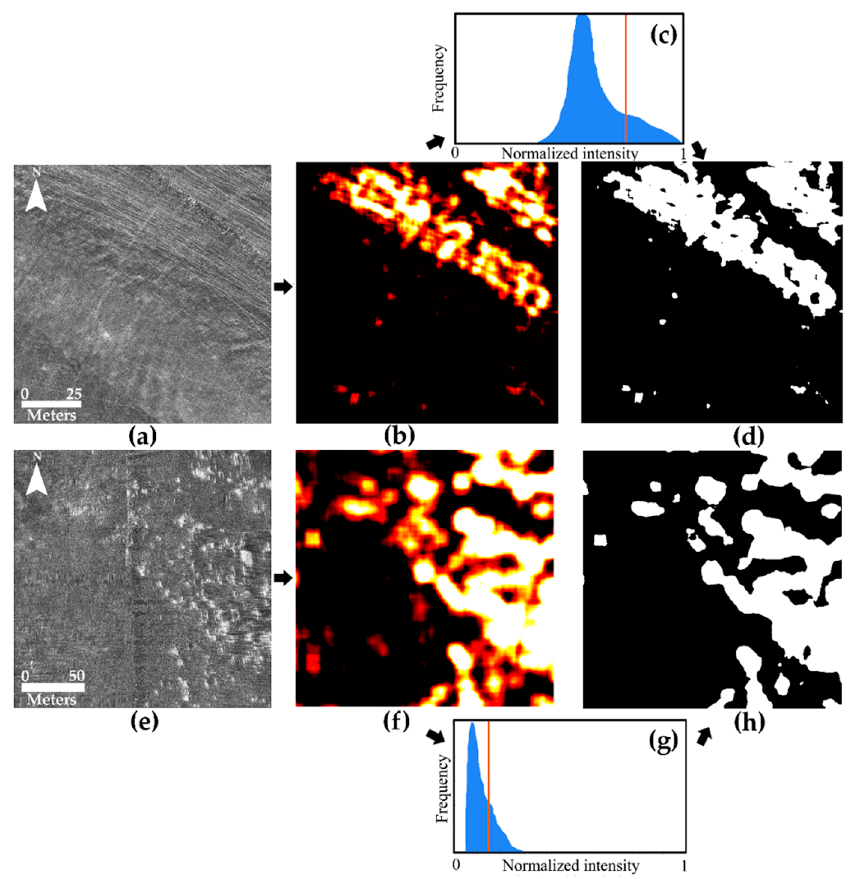
Figure 10. ( a ) SSS mosaic area with plain sand and TMs, ( b ) the Anisotropy map of up-left image, ( c ) the Anisotropy histogram with vertical orange line indicating the threshold used, ( d ) fishing-grounds segmentation map using the Anisotropic threshold. ( e ) SSS mosaic area with plain sand and biogenic mounds, ( f ) the Complexity map of low-left image, ( g ) the Complexity histogram and the Complexity threshold, ( h ) biogenic mounds segmentation map using the Complexity threshold.